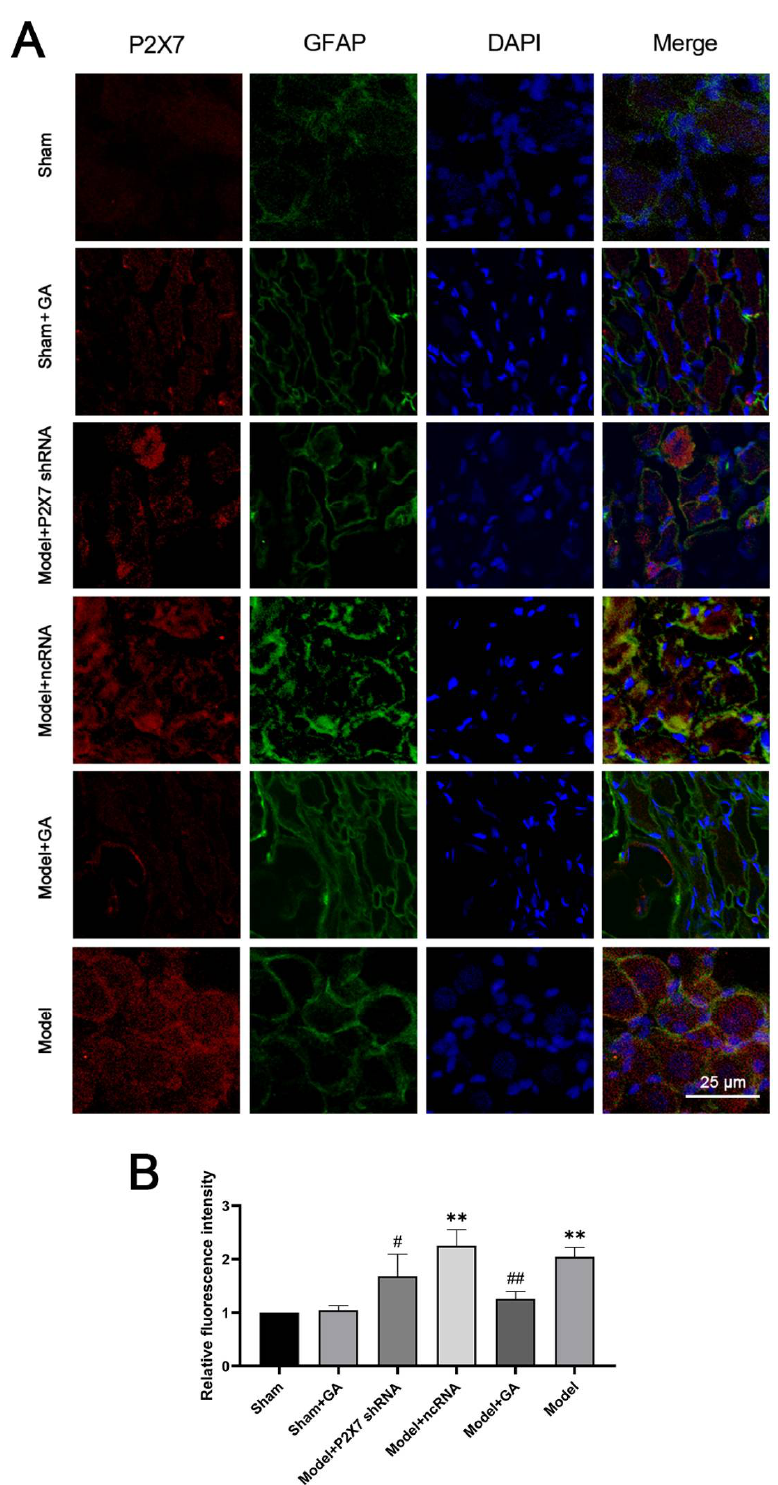
Figure 6. The effects of gallic acid on the co-expression of P2X7 and glial fibrillary acidic protein (GFAP) in the DRG. The blue signal indicates nuclei; the green signal indicates GFAP; and the red signal indicates the P2X7 receptor ( A ). The relative fluorescence intensity analysis (yellow) of the DRG ( B ) (F(5,30) = 31.126, p < 0.001). Values are means ± SEM. N = 6 per group. ** p < 0.01 vs. sham group; # p < 0.05 and ## p < 0.01 vs. model